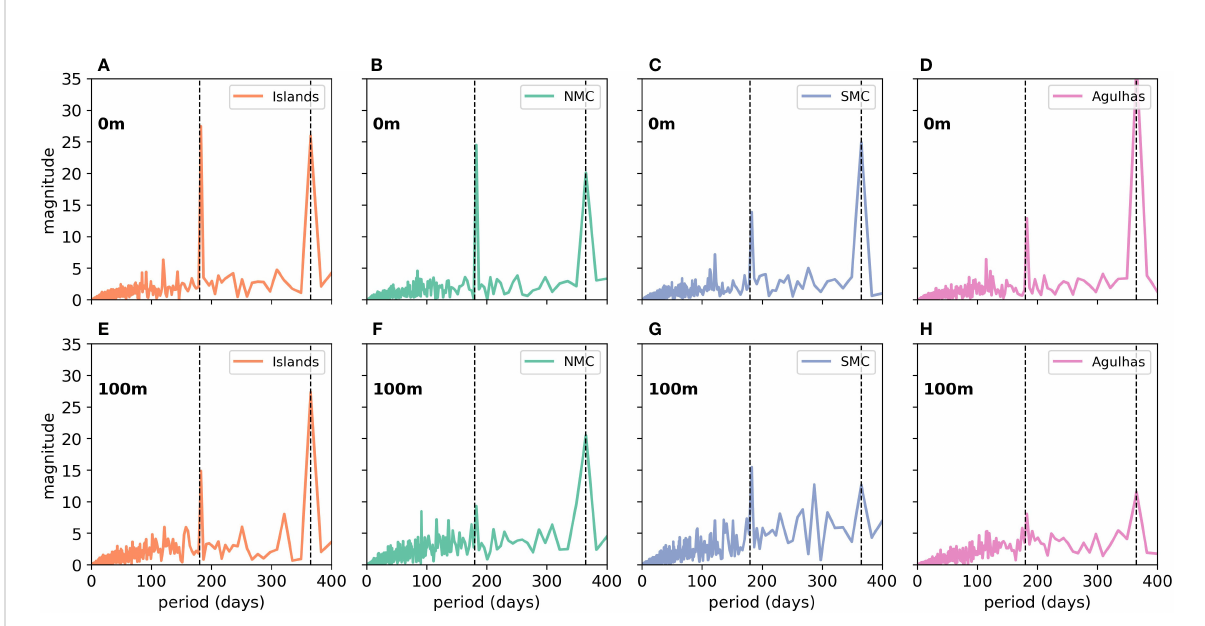
FIGURE 6 Fast Fourrier Transform analysis periodograms of MOZ36 front intensity in the 4 subregions: Islands (A, E) , NMC (B, F) , SMC (C, G) , Agulhas (D, H) and at two depths: surface (A-D) , -100 m (E-H) . The dashed vertical lines represent periods of 6 and 12 months. -500 m and -1000 m periodograms are not shown here because they did not show any signi fi cant magnitude peak, they are available as Supplementary Material, Figure